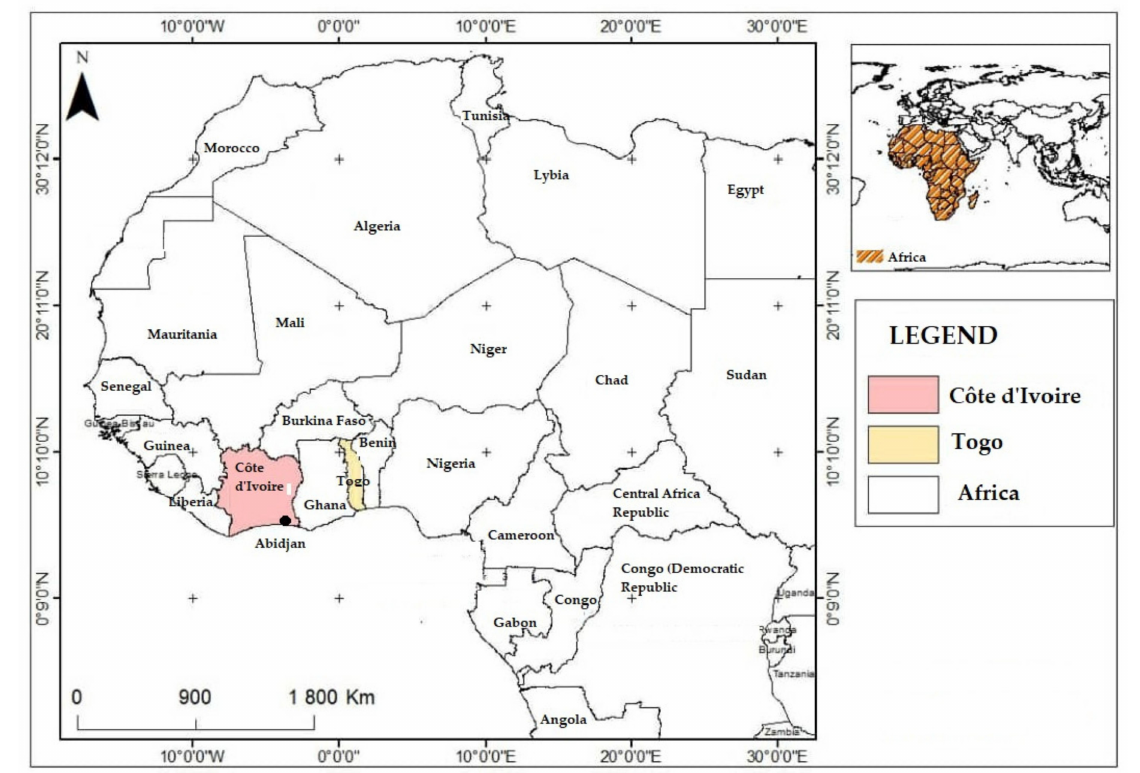
Figure 1. Study area location: Abidjan (C ô te d’Ivoire); and Lom é municipality (Togo). Reference: www.divas-gis.org, accessed on 5 March